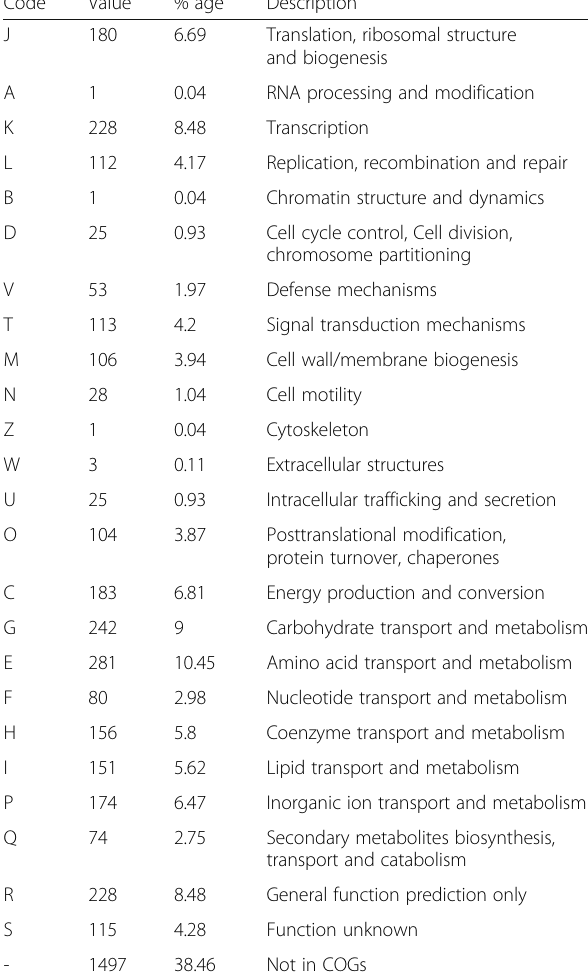
Table 4 Number of genes associated with general COG functional